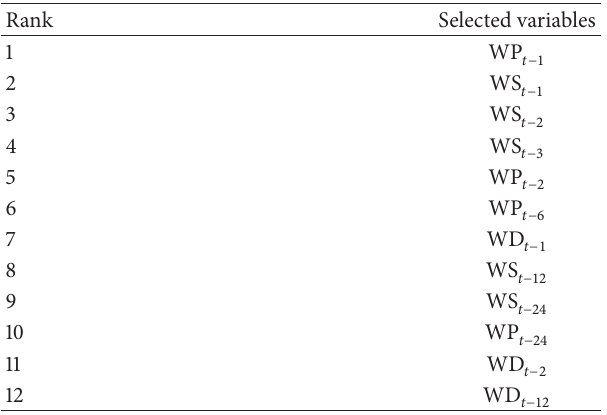
Table 2: Selected input variables for forecasting WP 𝑡 for the first test day of April